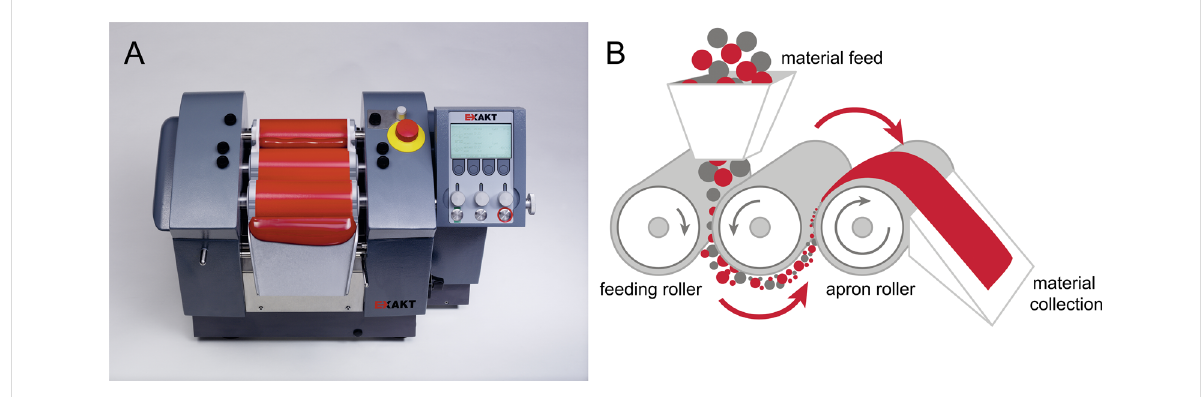
Figure 6: (A) Calendering mill, and (B) its working principle. Images reproduced with permission from [56], copyright 2016 EXAKT Advanced Technol- ogies, Germany.